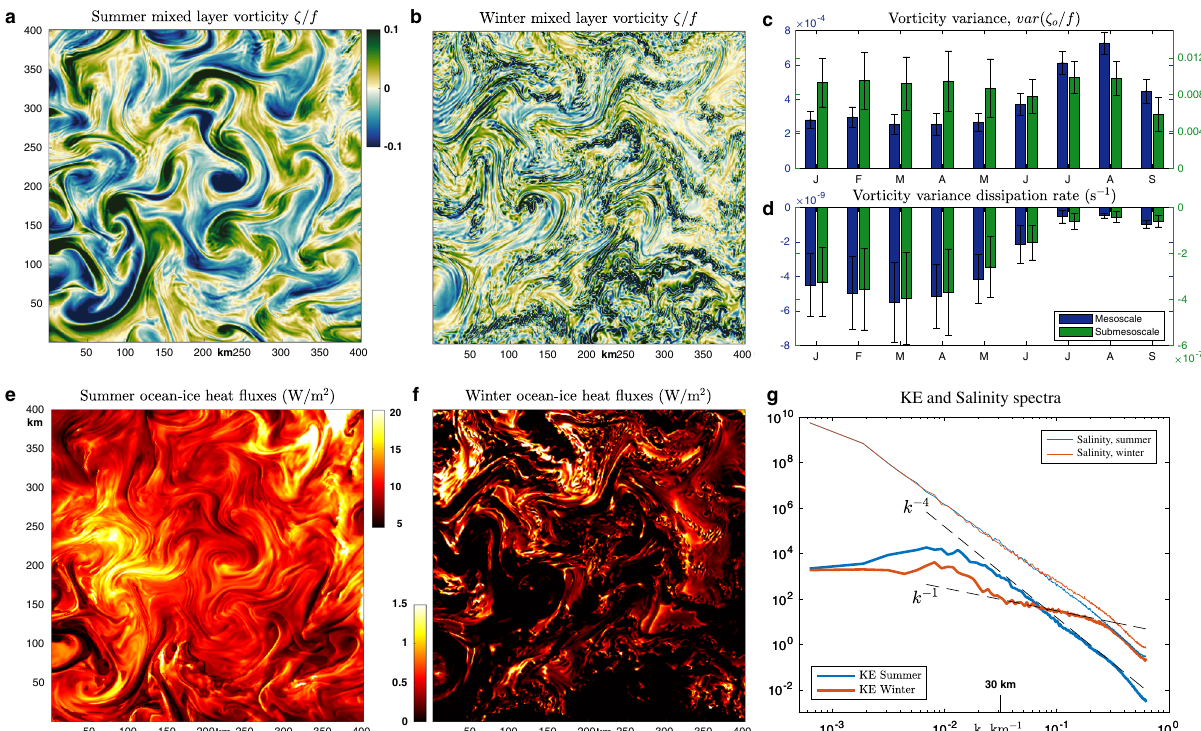
Fig. 3 Seasonal variations in upper-ocean variability and ocean-ice heat fl uxes demonstrating the dominance of small-scale processes in ice-ocean interactions. a , b Snapshots of ocean vorticity, normalized by the Coriolis parameter f , at the end of summer (1 September 2012) and the end of winter (1 March 2012).Maximum values reach ~0.3, but the color bar is saturated at 0.1 to highlightmesoscale features. e , f Snapshots of summer and winter ice- ocean heat fl ux, respectively. The sea ice cover is ~100% for the winter snapshot and ~60% for the summer. c Seasonal evolution of the monthly-mean variance of ocean vorticity at 20 m depth normalized by f and d monthly-mean and domain-averaged dissipation rate of the ocean vorticity variance (with vorticity also normalized by f ) due to ice-ocean stress (see Eq. (2)). These values are plotted for fl ows in mesoscale (blue bars) and submesoscale (green bars) ranges, which are separated by 30-km spatial fi ltering. The error bars represent standard deviations based on daily variability within a given month. g Spectra of near-surface kinetic energy (thick curves) and salinity (thin curves) were diagnosed at 20 m depth for summer (blue colors) and winter (red colors) months. Under-ice-ocean density is governed by salinity and hence its spectrum is closely related to the potential energy spectrum. Dashed curves denote k − 1 and k − 4 power-laws for reference. A 30-km wavelength, indicated in g , was used to fi lter mesoscale from submesoscale motions in c and d